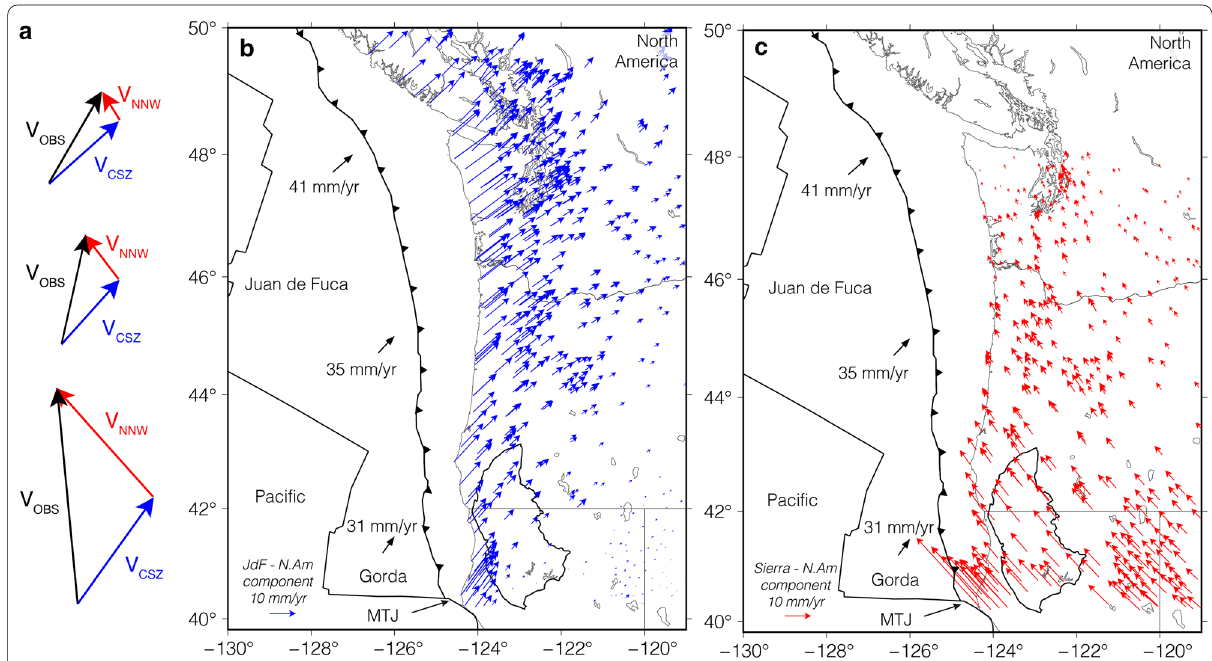
Fig. 3 Cascadia GPS vector decomposition results. a Example vector triangles illustrating the decomposition methodology (V OBS : observed GPS velocity; V CSZ : Cascadia subduction zone component of velocity; V NNW : NNW-shortening component of velocity) and general patterns from north to south. Maps showing the decomposition results. b NE-directed (subduction coupling) component of the GPS velocity field. c NNW-directed (shortening) component of the GPS velocity